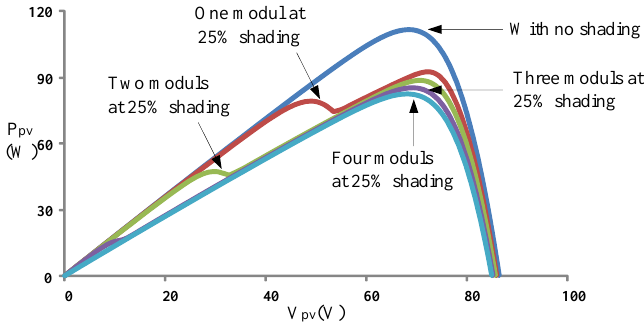
Figure 2. Power–voltage (P–V) curves of the 4-series 1-parallel array when different numbers of modules were at 25% shading.